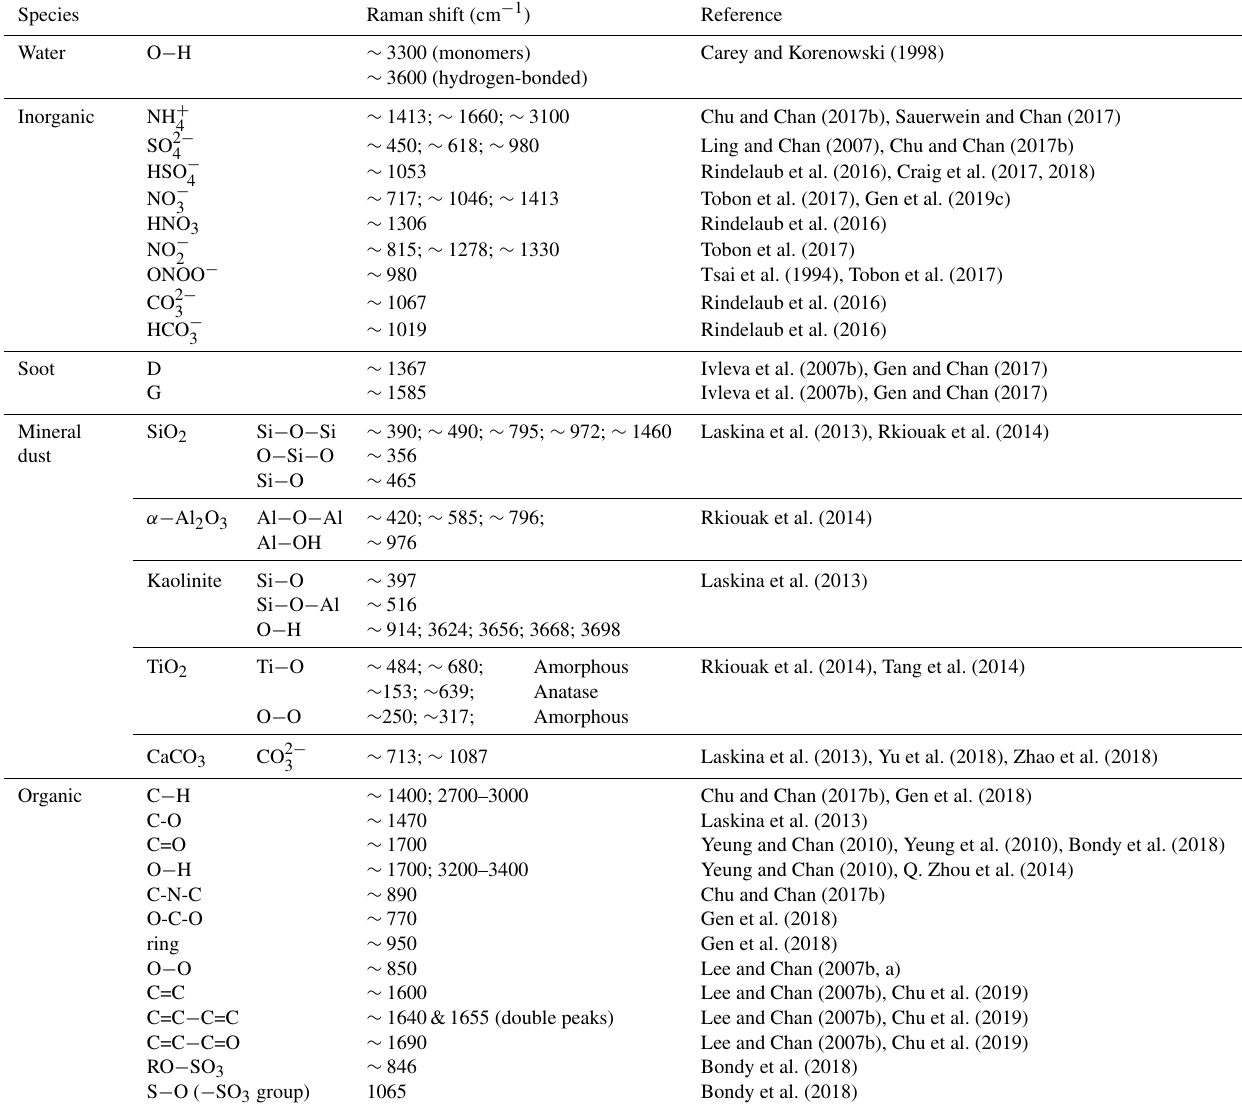
Table A1. Major Raman peaks of atmospherically relevant